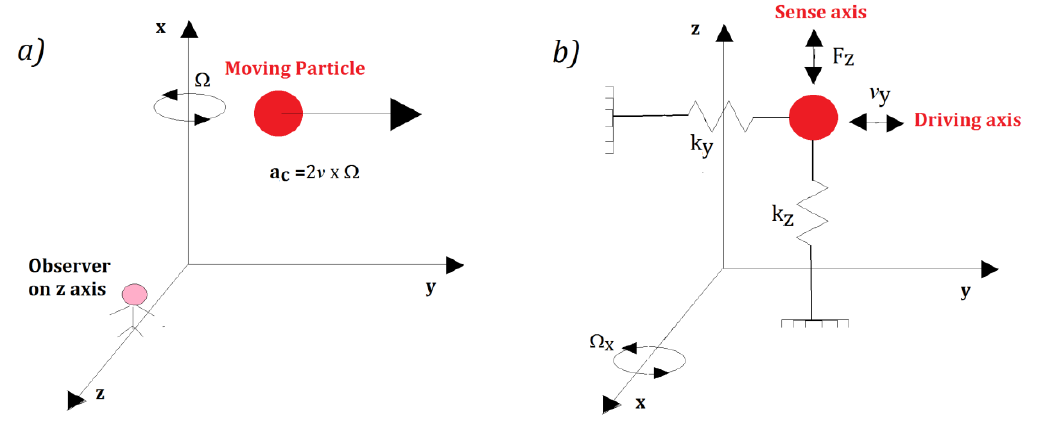
Figure 9. ( a ) Coriolis acceleration (a c ) acting on a moving particle; and ( b ) mass-spring model of a MEMS gyroscope.